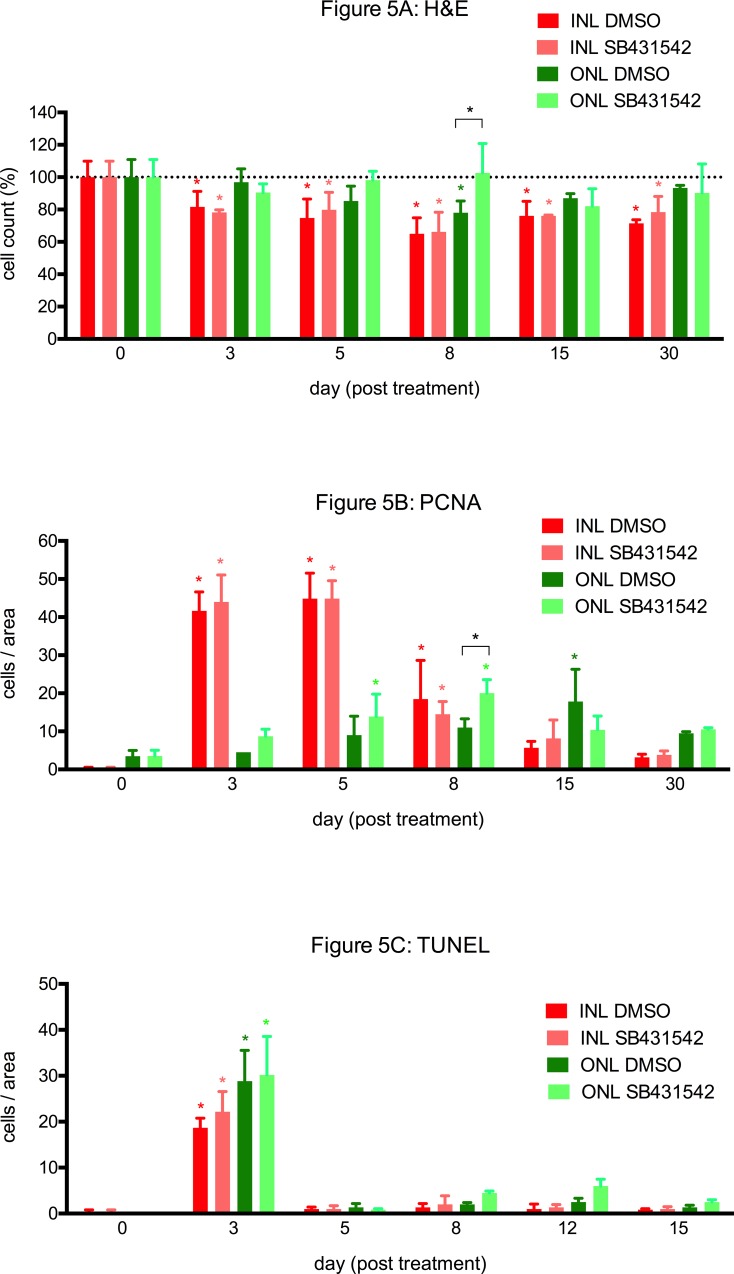
Cell quantifications of H&E, PCNA and TUNEL stainings.A. After the induction of retinal degeneration, cell loss in the outer nuclear layer (ONL) was observed in H&E stained paraffin sections. In zebrafish in which TGFβ signaling was inhibited (ONL SB431542), the cell count in the ONL was slightly decreased at day 3 compared to the baseline level (uninjured retina; day 0) but rapidly returned to it thereafter. Alternatively, in the uninhibited group (ONL DMSO), the cell count remained reduced until day 8. Compared to the baseline level, the number of cells of the INL of both groups (INL DMSO and INL SB431542) was significantly reduced beginning at day 3, and this reduction persisted up to day 30. B. After the induction of retinal degeneration using MNU, a significant increase in PCNA-positive cells, indicating proliferation, was observed in the INL (INL DMSO and INL SB431542) between days 3 and 8 (peaking at days 3 and 5). Whereas the maximal increase in PCNA-positive cells in the ONL was observed at days 5 and 8 in the TGFβ-inhibited group (ONL SB431542), this increase was the highest at day 15 in the uninhibited group (ONL DMSO). Overall, the inhibited group exhibited significantly more PCNA-positive cells than the uninhibited group (p<0.05 at day 8). C. The most TUNEL-positive cells, indicating apoptosis, were observed at day 3 in the ONL and the INL of both the TGFβ-inhibited (SB431542) and uninhibited groups (DMSO). In addition, some TUNEL-positive cells were observed at days 8 and 12 in the ONL of the TGFβ-inhibited group (ONL SB431542). The asterisks (*) indicate a significant difference (p<0.05) compared to baseline, and the asterisks with squared brackets indicate a significant difference (p<0.05) between inhibited and uninhibited TGFβ signaling.